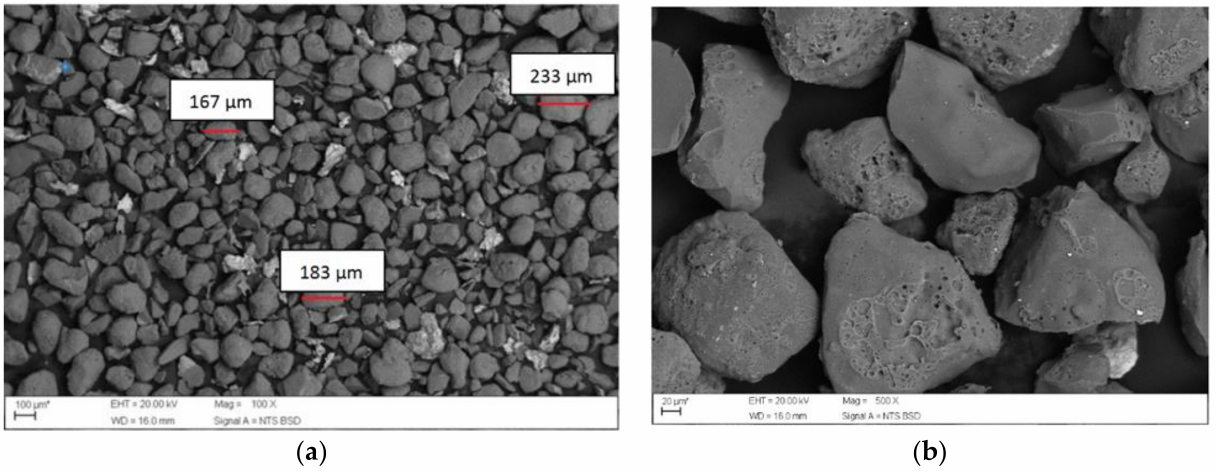
Figure 4. SEM by Back-Scattered Electron (BSE), ( a ) with 100 × and ( b ) 500 ×